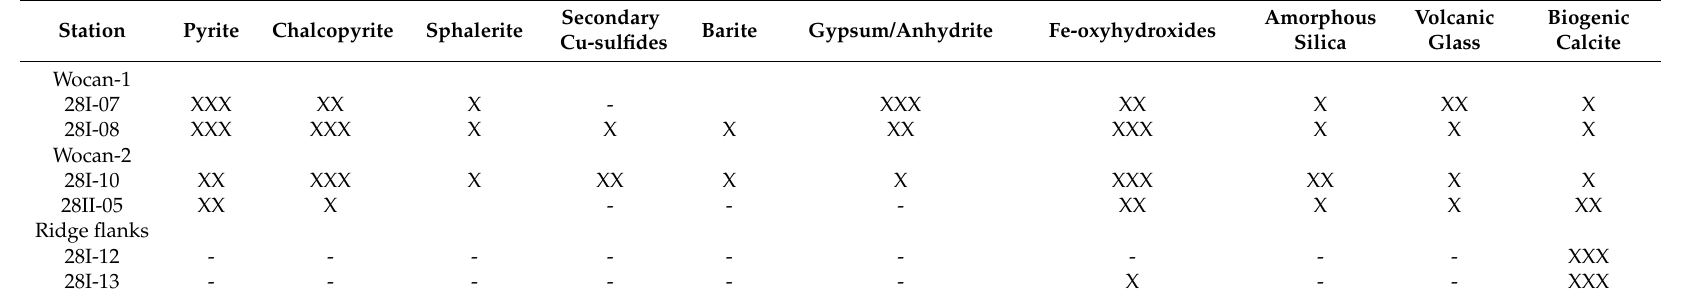
Table 2. Qualitative mineral assemblages of Wocan-1 and Wocan-2 metalliferous sediments and the ridge flank